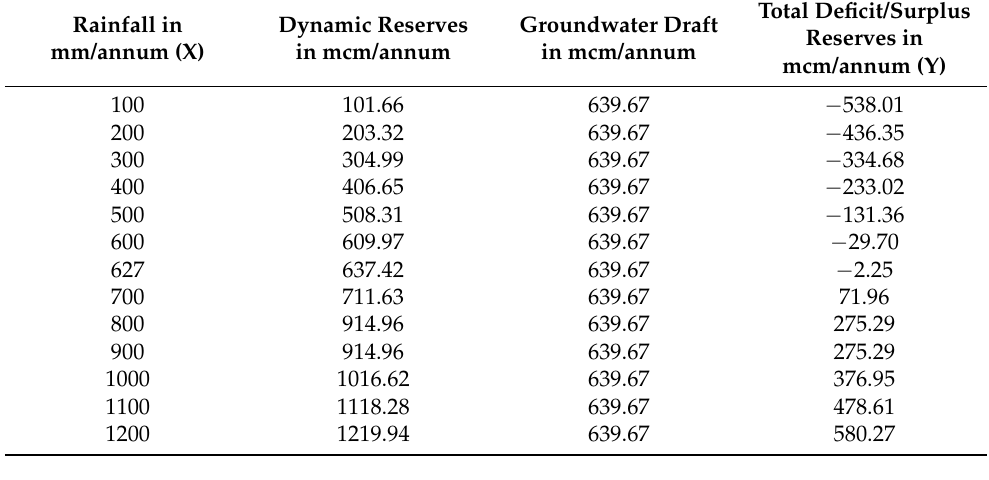
Table 4. Deficit/Surplus reserves at different rainfall events.